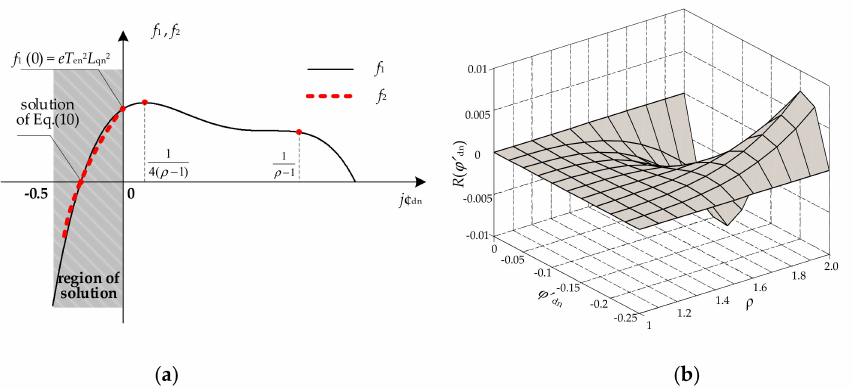
Figure 5. The schematic diagram of the interpolation trajectory and remainder. ( a ) Interpolation; ( b ) remainder of